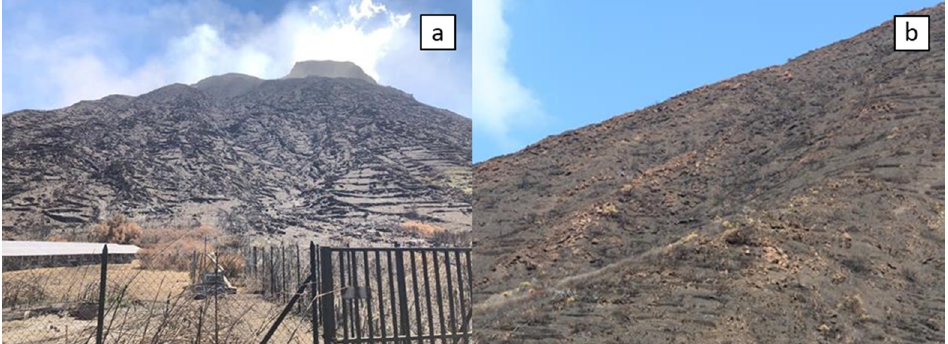
Figure 9. Damages to the adjacent area of the photovoltaic power station in ( a ), damages to the ancient terraced olive groves in ( b ) at Ginostra, following the 3 rd July 2019 paroxysmal explosion.